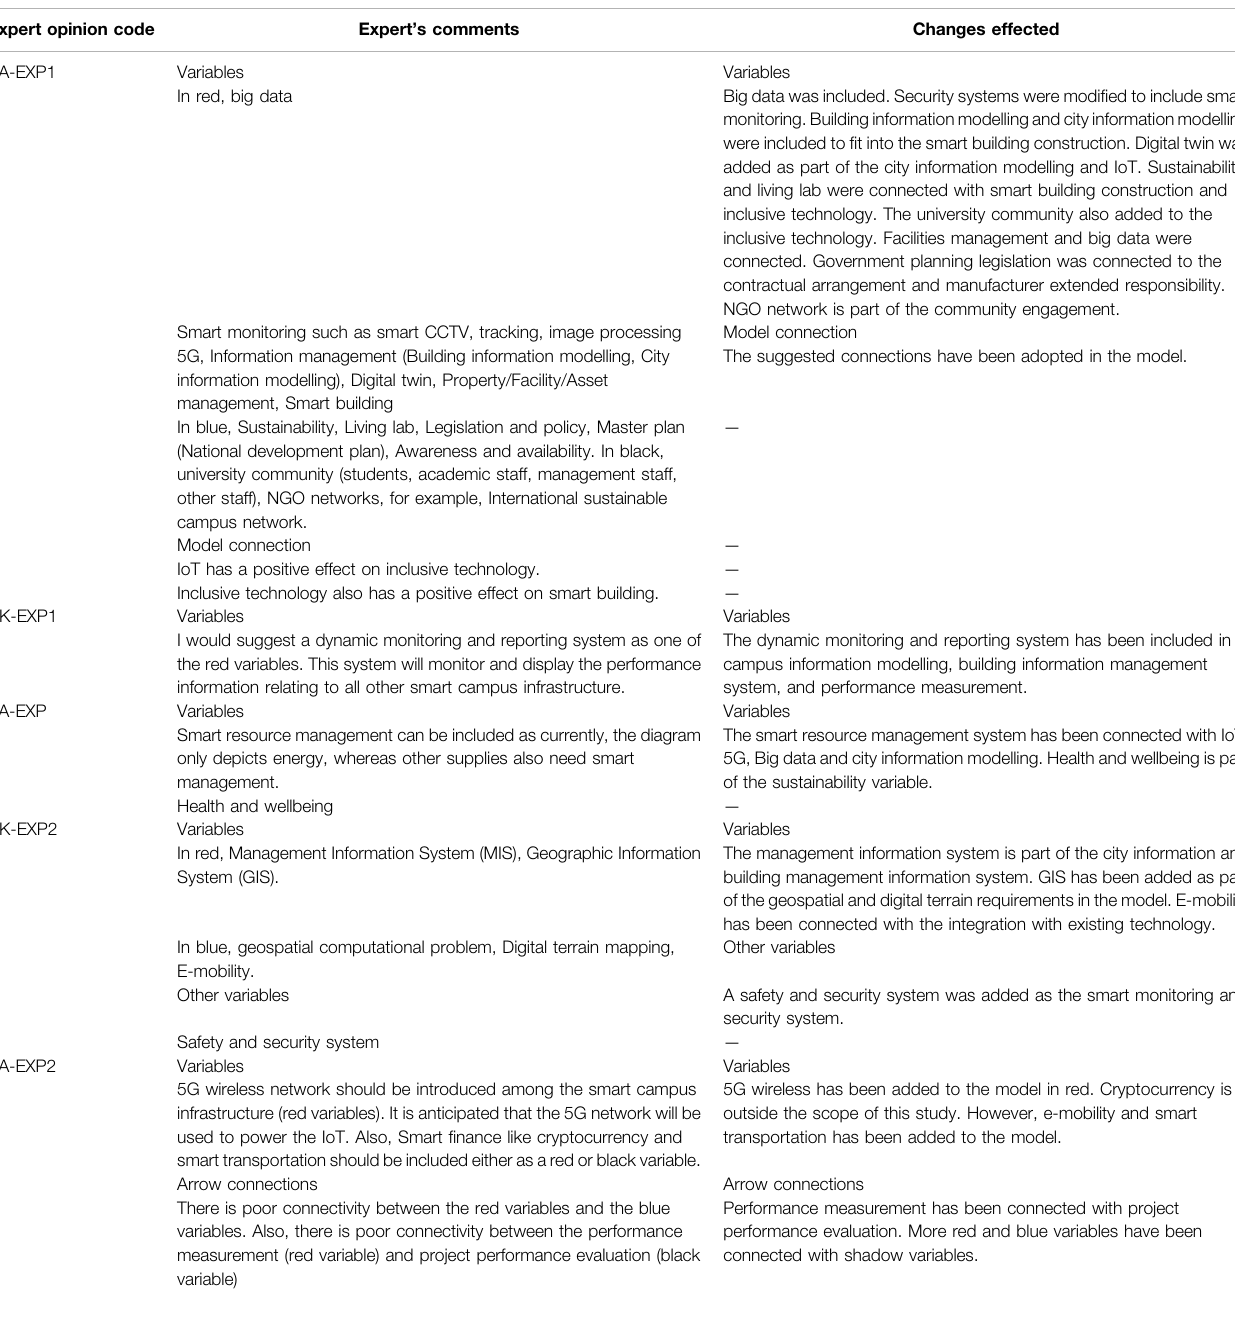
TABLE 3 | Summary of fi ndings of expert opinions. Source: